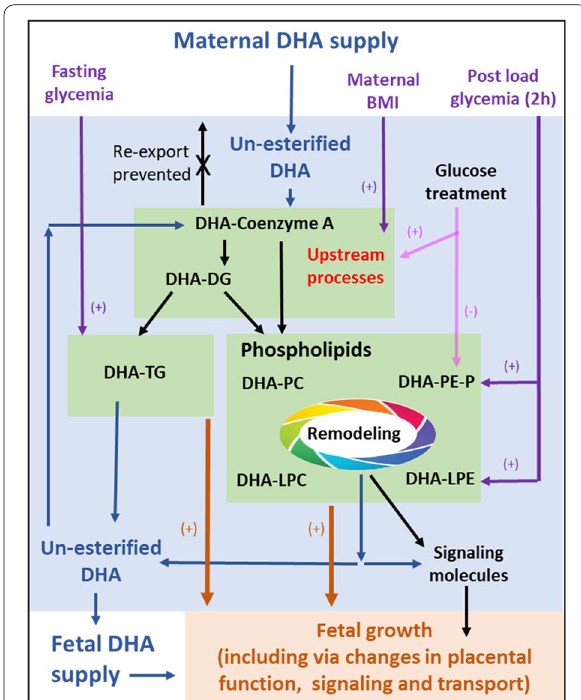
Fig. 7 Placental DHA metabolism regulates the amount of DHA available for the synthesis of signaling molecules and for fetal supply. The conversion of DHA into DHA‑COA and lipids such as diacylglycerols (DG), triacylglycerols (TG), or phospholipids such as phosphatidylcholine (PC) or phosphatidylethanolamine‑plasmalo gen (PE‑P) traps DHA in the placenta and prevents re‑export. DHA released from lipids (blue arrows), may be remade into lipids, used to form signaling molecules such as eicosanoids or exported to the fetus. In our experiments, increased BMI (purple) and in‑vitro glucose treatment (pink) was associated with the increased synthesis of most 13 C‑DHA‑lipids, suggesting that upstream processes such as activation into DHA‑CoA or the early stages of lipid synthesis may be affected. Glucose treatment also decreased PE‑Ps suggesting a separate PE‑P specific process may also be affected. Fasting glycemia (purple) is only associated with TGs, suggesting a link with TG specific processes. DHA lipid metabolism and change in response to